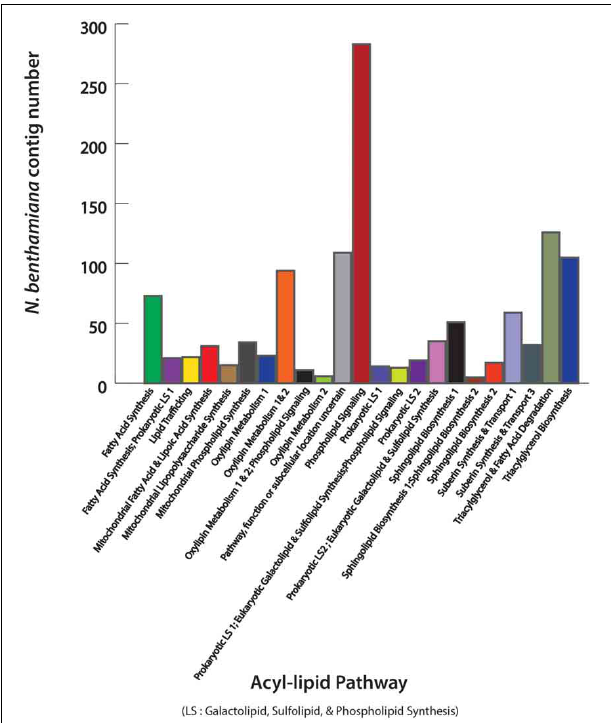
FIGURE 2 | Identification of leaf acyl-lipid metabolism transcripts of N. benthamiana . Contigs mapped to A. thaliana sequences were searched against “The Arabidopsis Acyl-Lipid Metabolism” website (ARALIP; http://aralip.plantbiology.msu.edu) to identify acyl-lipid related transcripts. Distribution of identified transcripts into different acyl-lipid metabolism categories and number of contigs in each category is